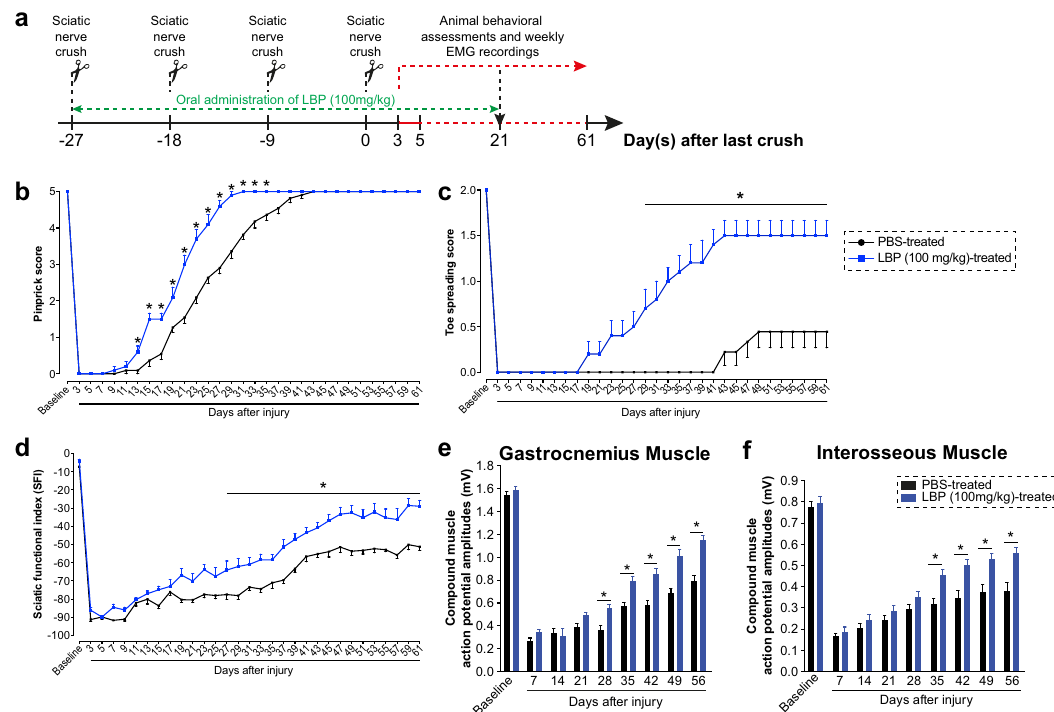
Fig. 3 LBP accelerates function recovery after severe peripheral nerve injury and promotes robust CNS axon regeneration. a Schematic diagram illustrating the experimental timeline for severe peripheral nerve injury and LBP (100 mg/kg) treatment paradigm. Sciatic nerve was crushed 4 times at 9-day intervals to prevent successful muscle re-innervation for motor function recovery. b Pinprick sensitivity was fully recovered at 31 days in LBP-treated mice and 43 days in vehicle control mice. c LBP-treated mice were able to regain 75% of the toe spreading re fl ex, whereas control mice only recovered 22% of toe spreading re fl ex at 2 months post-injury. d Sciatic function index of control mice remained signi fi cantly lower than that of LBP-treated mice from day 27 post-injury onwards. e, f Functional neuromuscular junction re- innervation was quanti fi ed by weekly electromyography recordings of proximal (gastrocnemius) and distal (interosseous) muscles. A signi fi cant improvement in the average compound muscle action potential amplitude in LBP-treated mice was observed, reaching up to 68.8% of recovery in the most distal interosseous muscle compared with their own baseline values. Mean ± SEM ( n = 13 per group); * P < 0.05; two-way ANOVA, followed by post hoc Bonferroni test in ( b – f